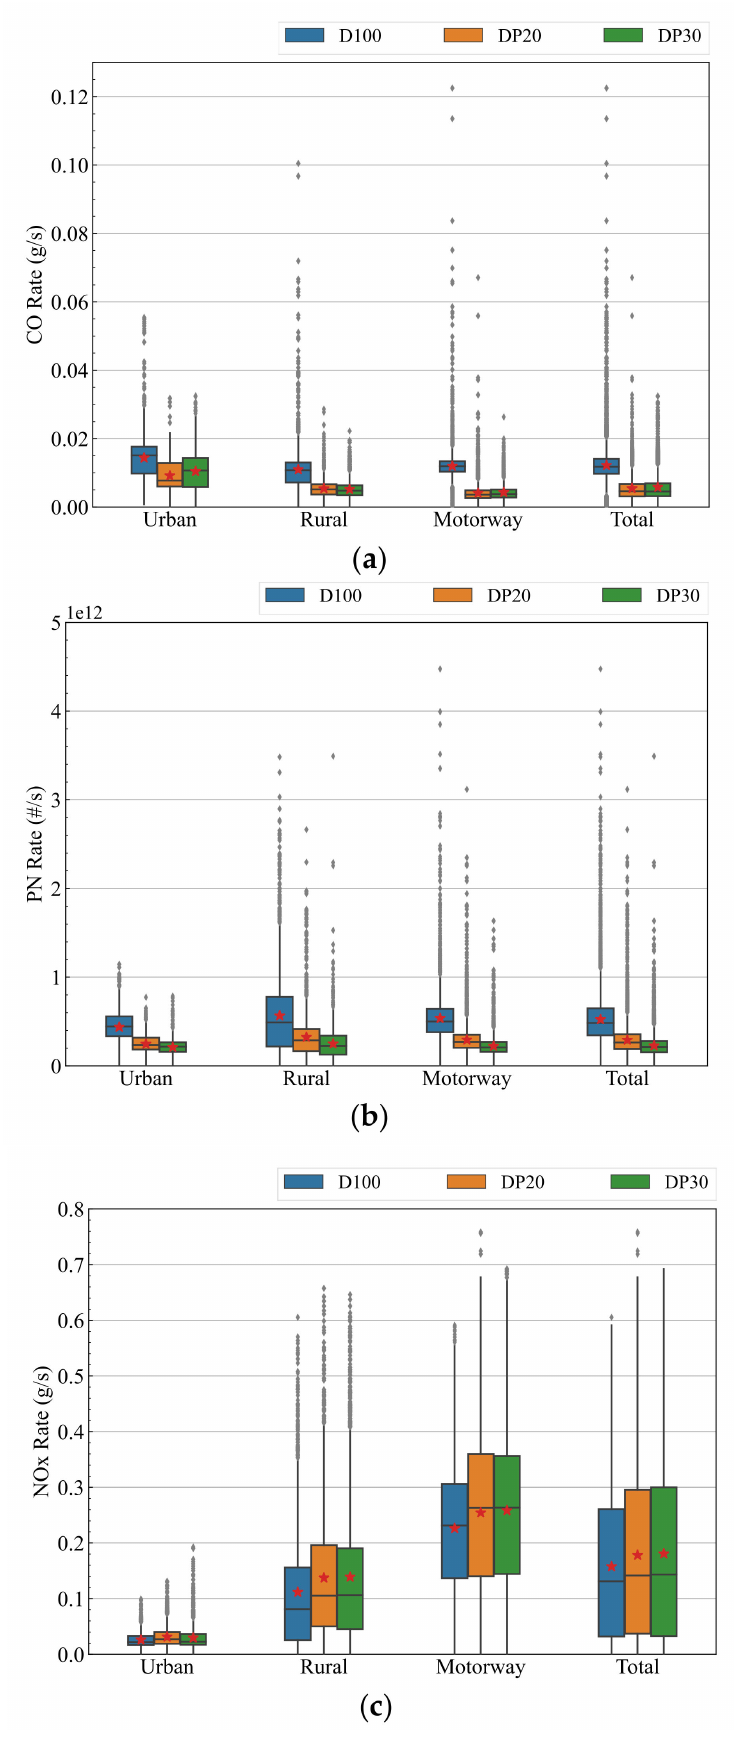
Figure 11. Boxplots of ( a ) CO, ( b ) PN and ( c ) NOx emission